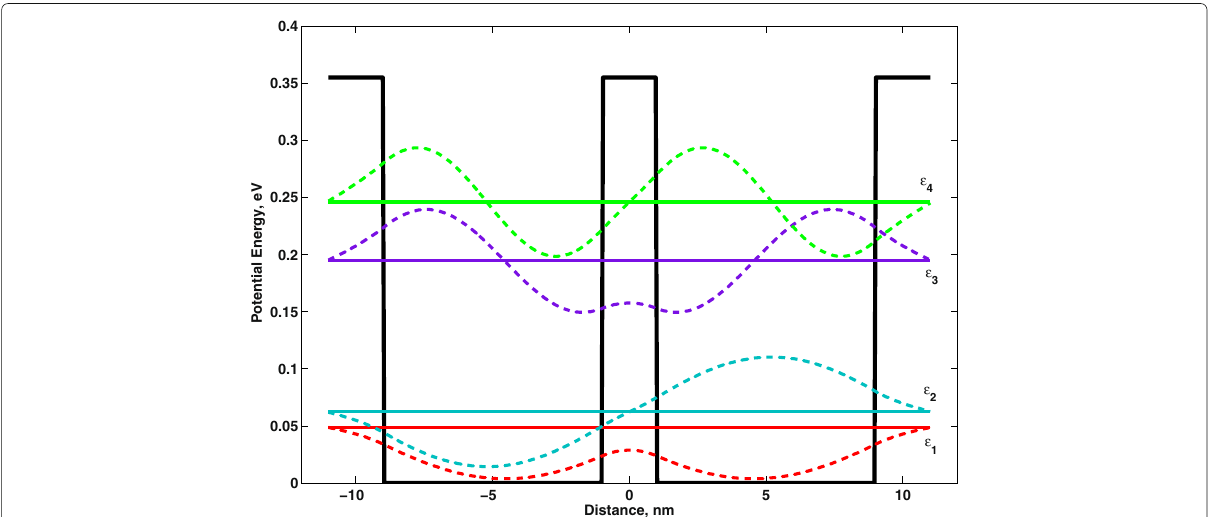
Fig. 1 The energy spectrum of Si 0.16 Ge 0.84 / Ge double quantum well and the corresponding stationary wave functions ( coloreddashedcurves )